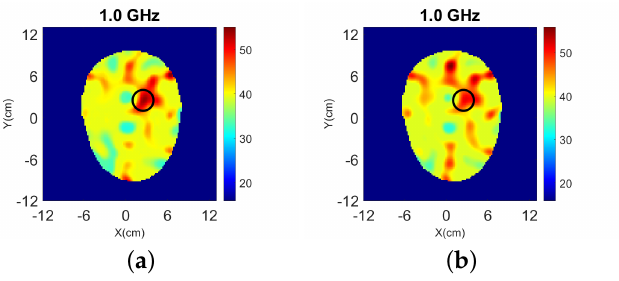
Figure 13. 2-D reconstructions of (cid:60) ( ε r ) at 1.0 GHz: ( a ) Case II.1, and ( b ) Case II.2. A cylindrical eight-antenna array centered at the target height is used to produce the data.